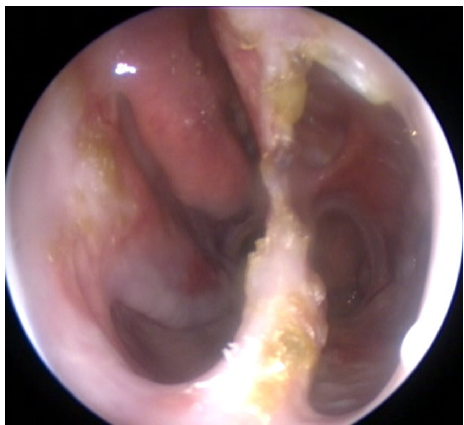
Figure 1. Nasal endoscopy. The laryngeal endoscopy revealed subglottic stenosis and free vocal cords, which were mobile with breathing and phonation. The stenosis had not progressed since the last follow-up (Figure 2).